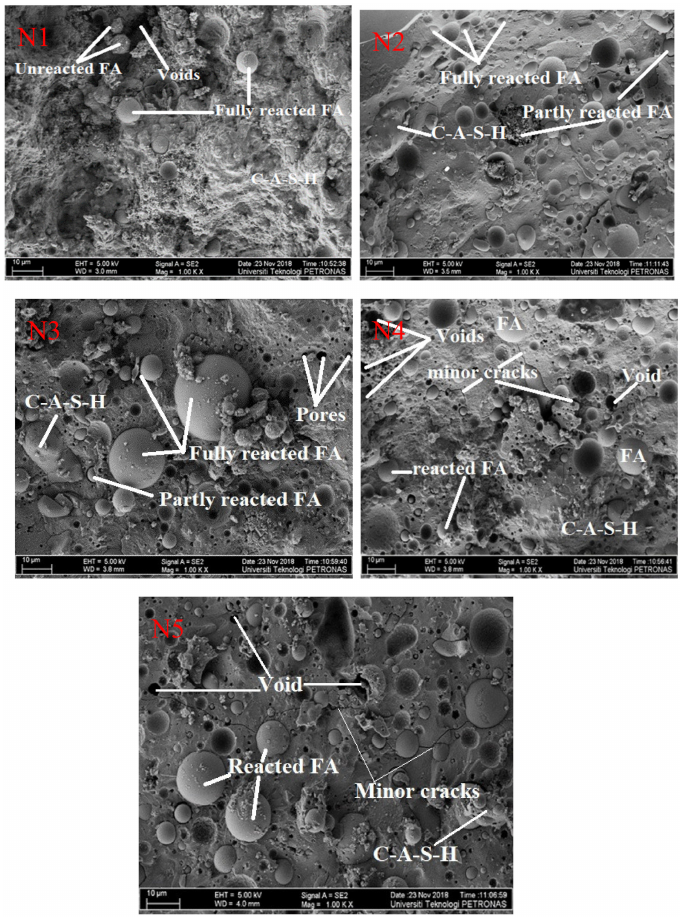
Figure 9. Field Emission Scanning Electron Microscopy Micrograph at different dosage of solid